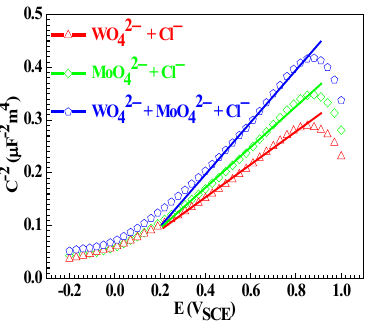
Figure 12. Mott–Schottky of the Q235 samples in WO 4 2− + Cl − , MoO 4 2− + Cl − and WO 4 2− + MoO 4 2− + Cl − solutions.